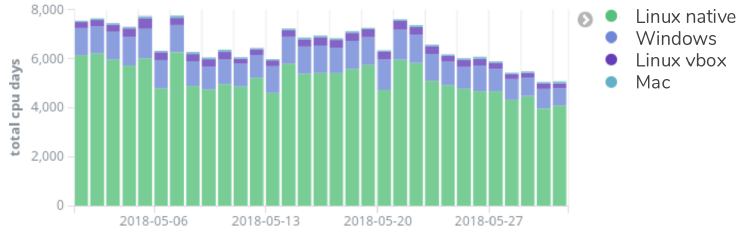
Figure 2. CPU day consumption per version of the ATLAS app during May